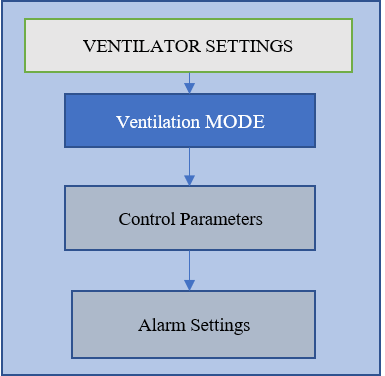
Figure 1. Types of ventilator settings applied in a shown sequence.